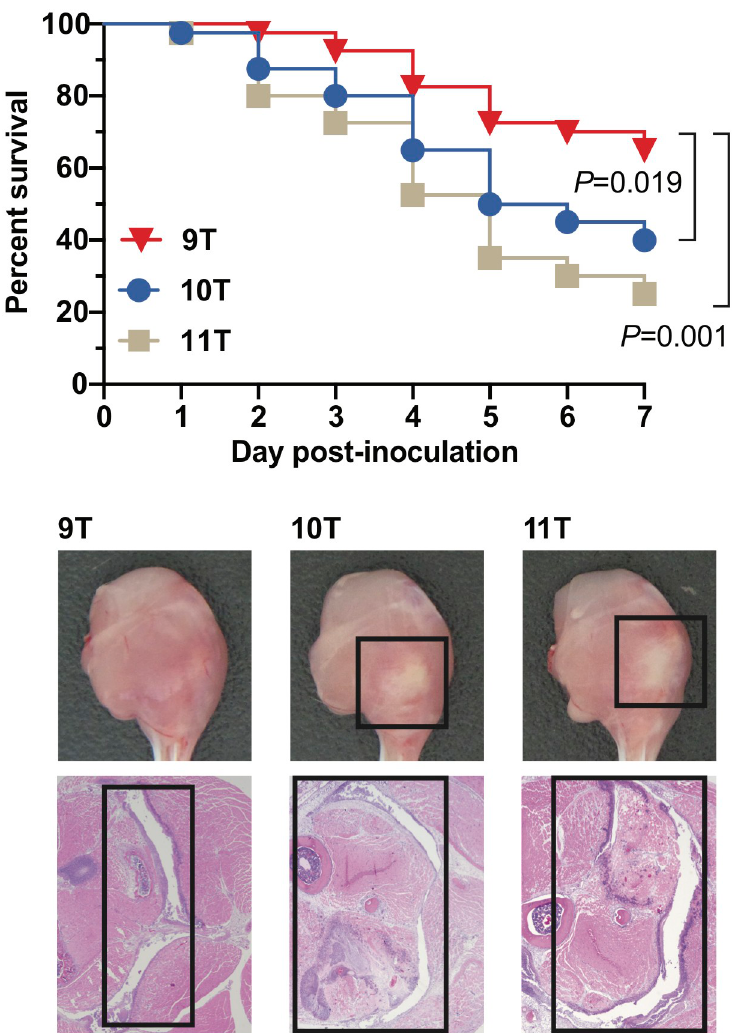
Fig 5. Virulence assessed in a mouse model of necrotizing myositis. (A) Virulence of 9T, 10T, and 11T isogenic strains in a mouse model of necrotizing myositis ( n = 40 mice per strain). The treatment groups’ size was based on a power calculation from results of a pilot study. Significantly increased near-mortality was observed for the 10T and 11T strains compared with the 9T strain. Significance was determined using the log-rank test. (B) Representative gross and microscopic pathology images of the hindlimb lesions from mice ( n = 5 mice per strain). Boxed areas demarcate areas with major